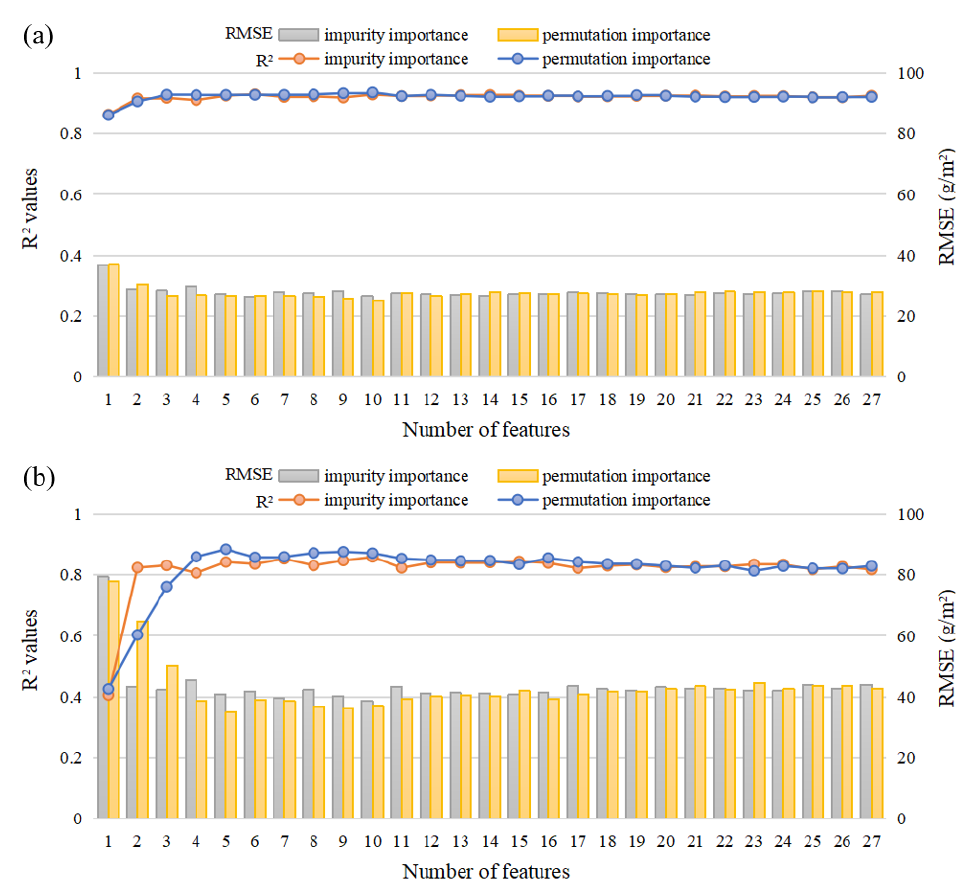
Figure 6. The performance of the AGB estimation models with the selected feature number changes based on the impurity and permutation importance. The left vertical axes (curves) and right vertical axes (bars) indicate the R² and RMSE of the estimation models. ( a , b ) show the model performance on the training and test sets, respectively.